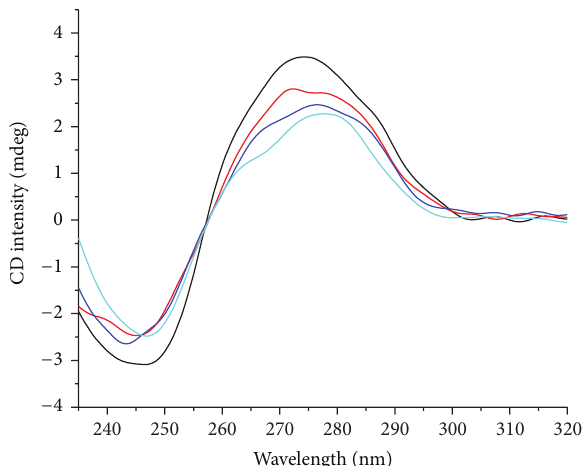
Figure 6: Circular dichroism spectra of DNA (80 𝜇 M) in 10mM Tris HCl buffer, in the presence of increasing amounts of copper(II) complex.